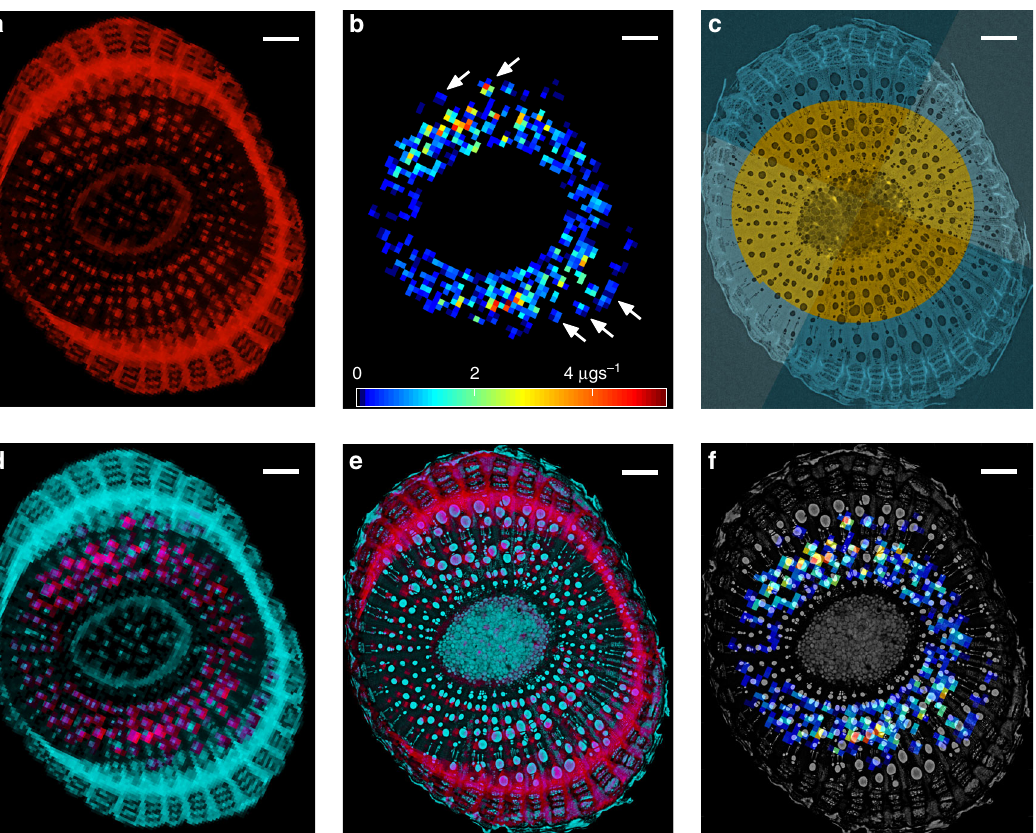
Fig. 2 Stem scans. a in vivo Magnetic Resonance Image (MRI) of a Vitis vinifera (L.) stem at 39 µ m resolution, image intensity follows water content. b MRI of in vivo water fl ow rates in the same segment at 78 µ m resolution; white arrows indicate signi fi cant fl ows in vessels of the outer domain. c X-ray micro- computed tomography ( μ CT) scan at 3.2 µ m resolution of the excised internode, where xylem is divided into inner (yellow) and outer (blue) domains as well as Dorsal-Ventral (darker wedges) and Lateral (lighter wedges) domains. d Overlap of ( a ) (red) and ( b ) (cyan). e Alignment of a with μ CT images: inverse μ CT intensity in cyan, MRI intensity in red, overlap in purple. f projection of volume fl ow map ( b ) onto μ CT image (greyscale). All scale bars are 0.5 mm long.